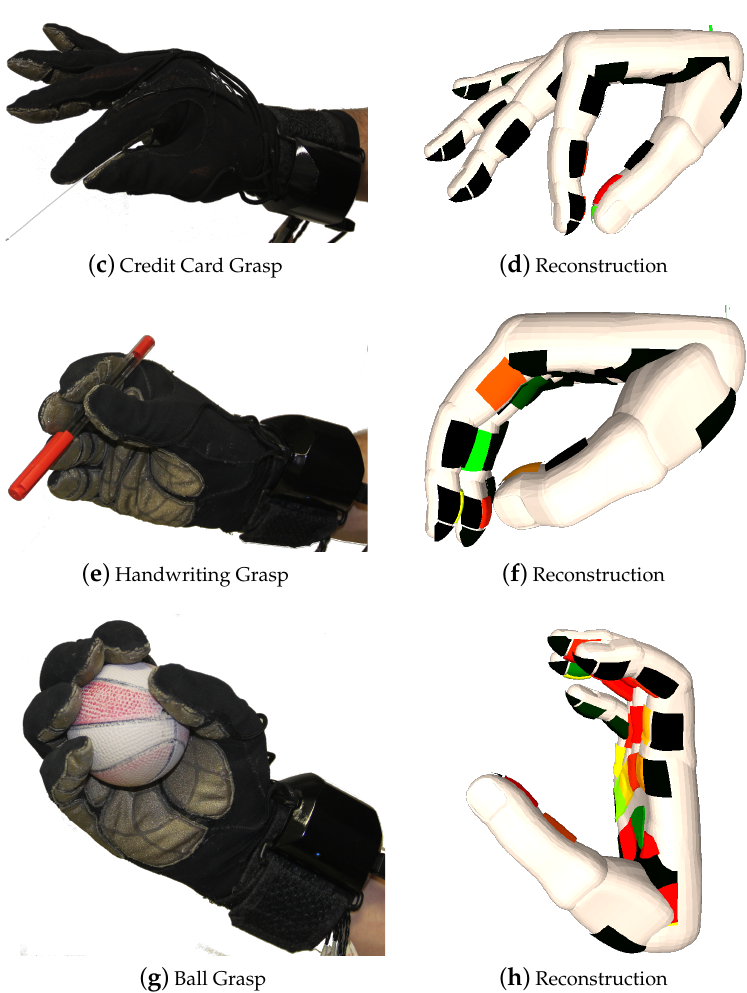
Figure 9. Side-by-side comparison of real and reconstructed